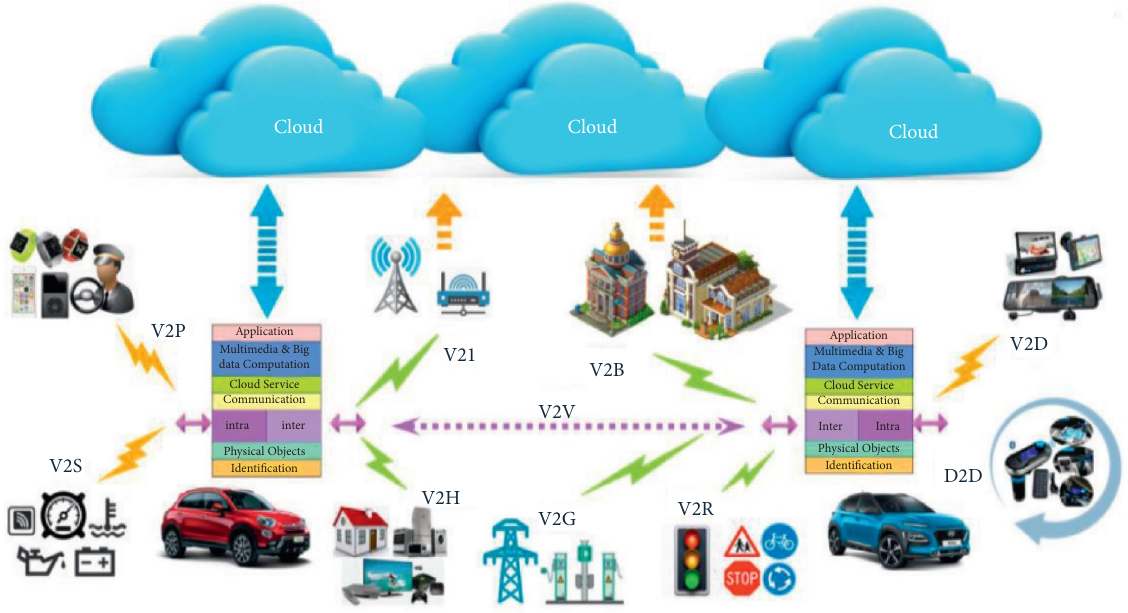
Figure 1: A universal Internet of Vehicles architecture for smart cities